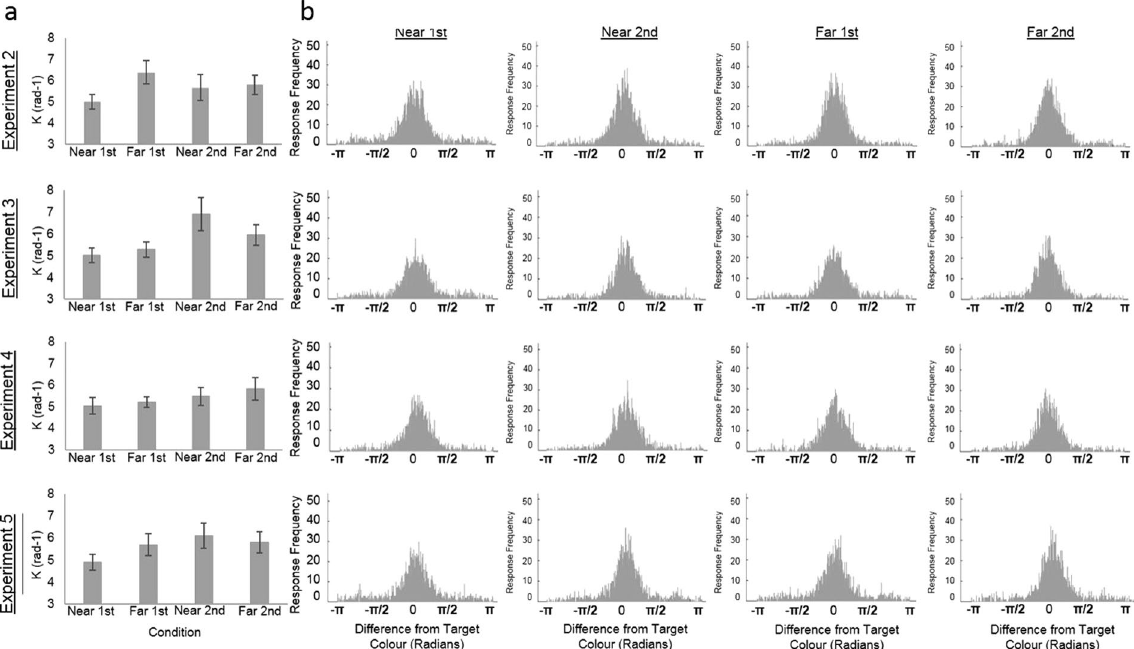
Figure 6. ( a ) The mean precision estimates (K) for each condition of Experiments 2–5, calculated using the mixture model 15 . Error bars represent the standard error. * Indicates p < 0.05 for paired t-tests between Near and Far conditions. ( b ) Distribution of responses relative to the target colour for the Near-First stimulus, Far- First stimulus, Near-Second stimulus and Far-Second stimulus conditions for Experiments